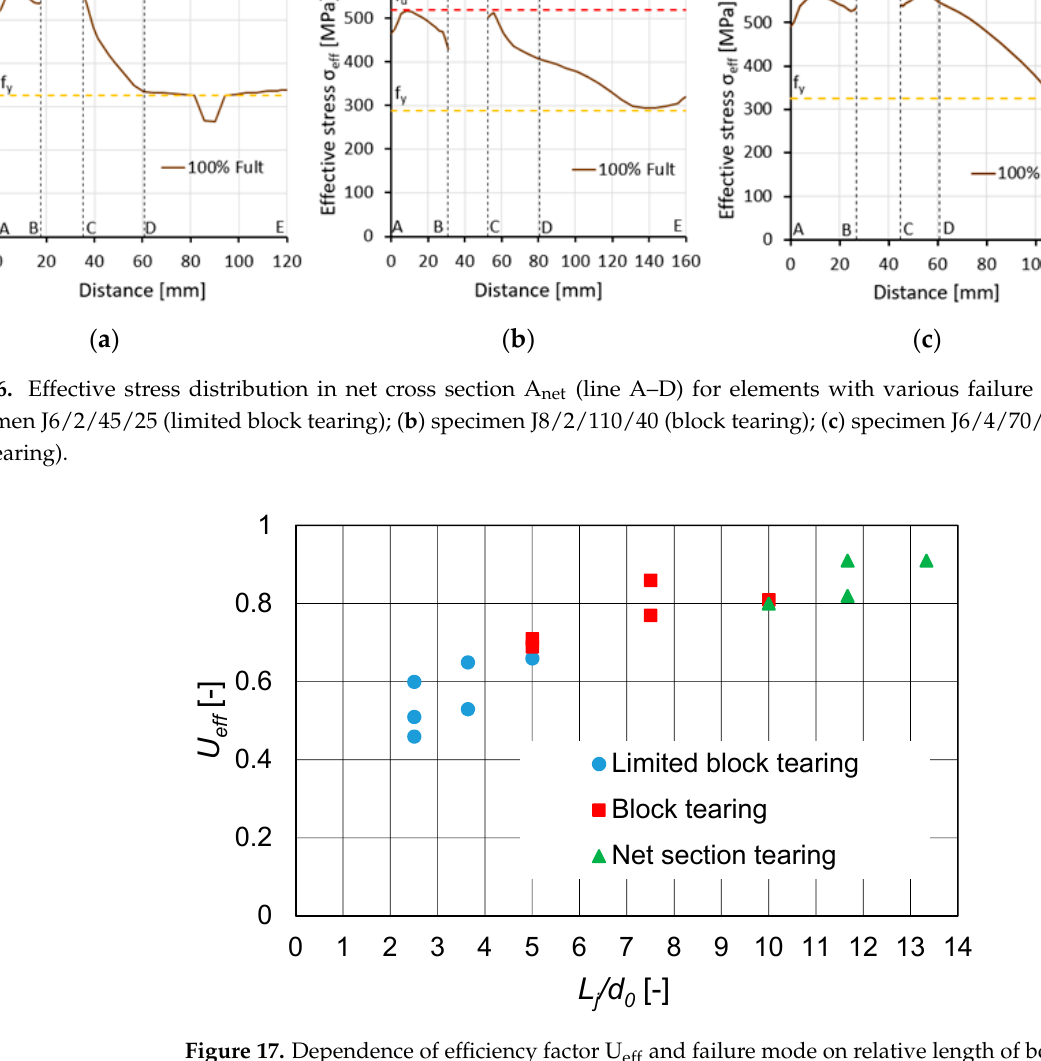
Figure 17. Dependence of efficiency factor U eff and failure mode on relative length of bolted connec- tions L j /d 0 .